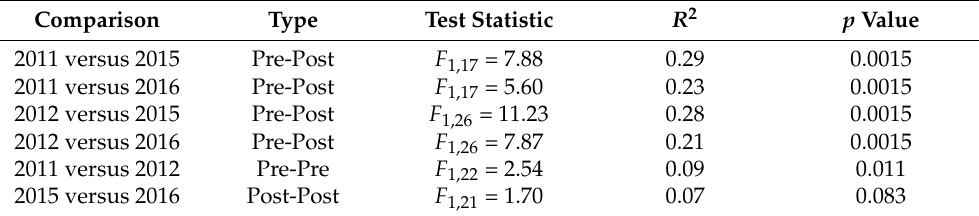
Figure 5. Nonmetric multidimensional scaling (NMDS) ordination plot of bee assemblages in reserve plots (squares) and fragment plots (circles) across four years of sampling. Points depicting sequential years of sampling at the same study plot are connected by dotted lines that terminate in an arrow at the point that depicts the last year of sampling for the plot. The ordination was constructed based on Bray-Curtis dissimilarity scores between all possible pairs of plot-year combinations. Dissimilarity scores were calculated based on relative abundances of bee species after standardizing the total abundance of each assemblage to a sum of 1. Statistical significance and R 2 value are indicated for each PERMANOVA independent variable: Y = study year, F = fragmentation status (reserves versus fragments); *** p ≤ 0.001. There was no statistically significant interaction between study year and fragmentation status. Table 1. Results of post-hoc PERMANOVA analyses comparing bee assemblage composition across all possible pairs of study years in both pre-drought (2011 and 2012, “Pre”) and post-drought (2015 and 2016, “Post”) conditions. Reported p values have been adjusted using Benjamini-Hochberg false discovery rate (FDR) correction for multiple comparisons.